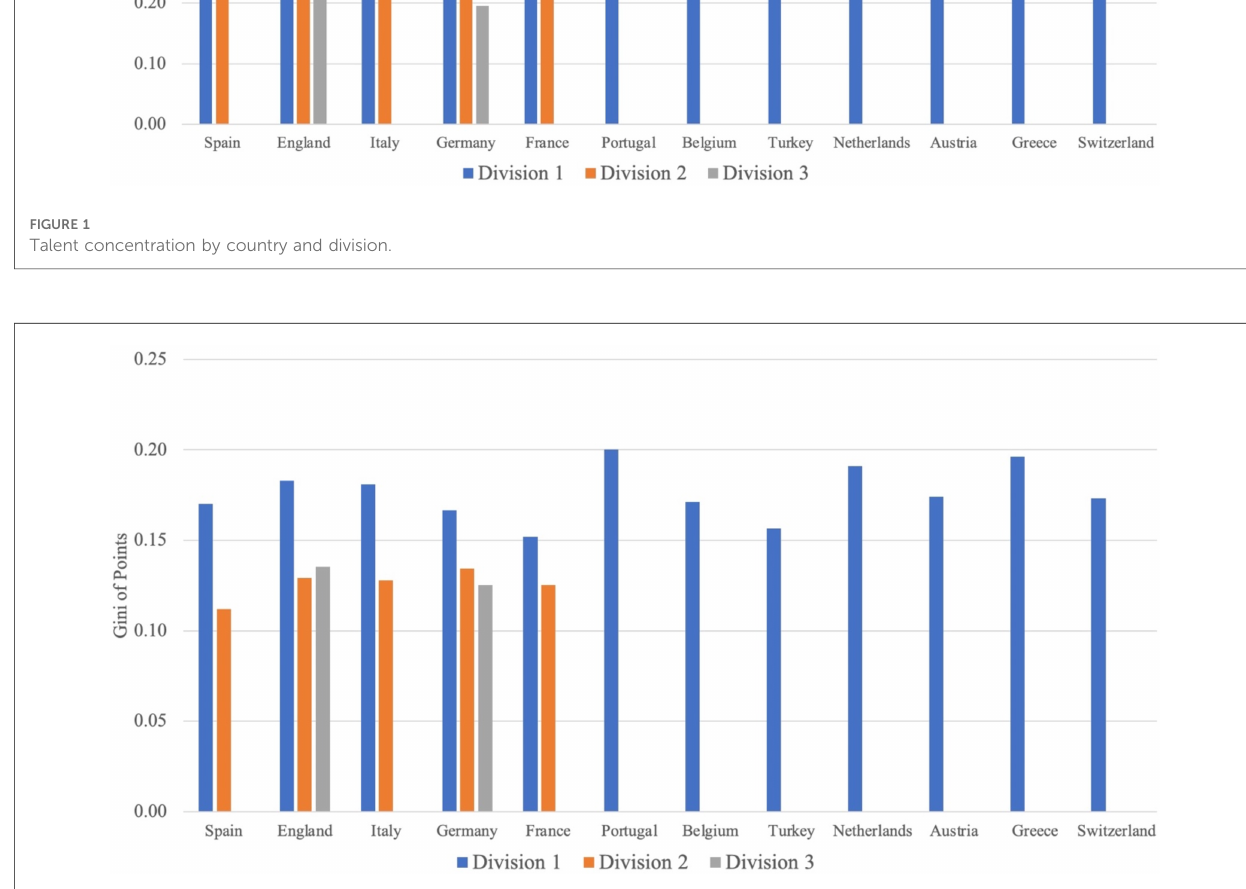
FIGURE 2 Gini of points concentration by country and